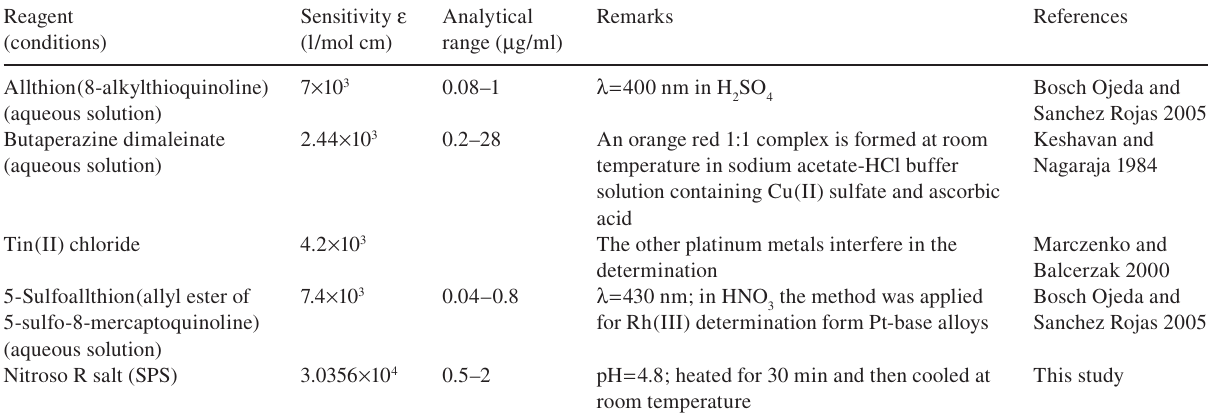
Table 3 Comparison of analytical performance of some spectrophotometric methods for Rh(III) determination.